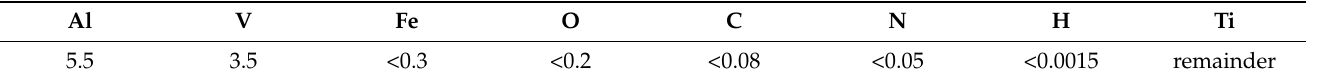
Table 1. Chemical composition of Ti-6Al-4V (wt.%).